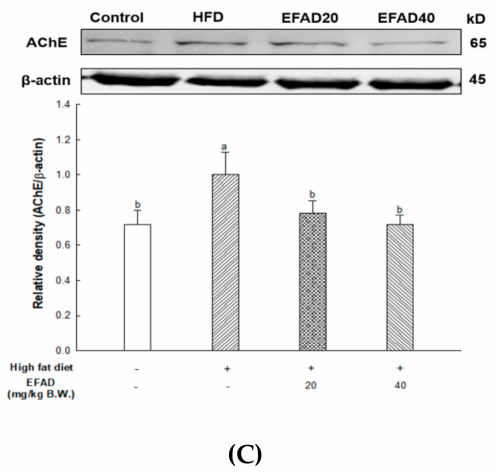
Figure 4. E ff ect of ethyl acetate fraction from Aruncus dioicus var. kamtschaticus (EFAD) on